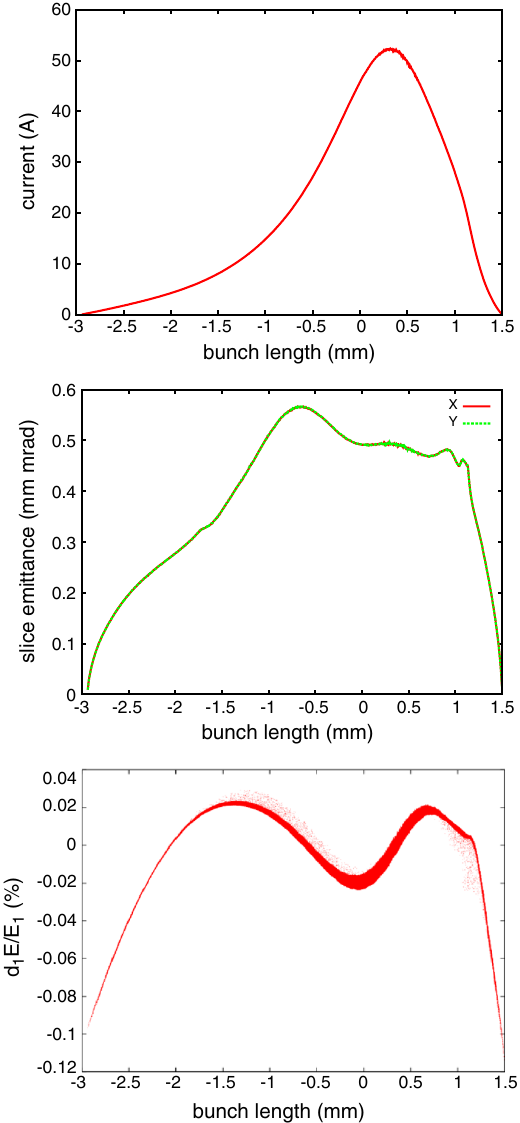
FIG. 3. Evolution of projected transverse rms emittance (100%) through the injector.